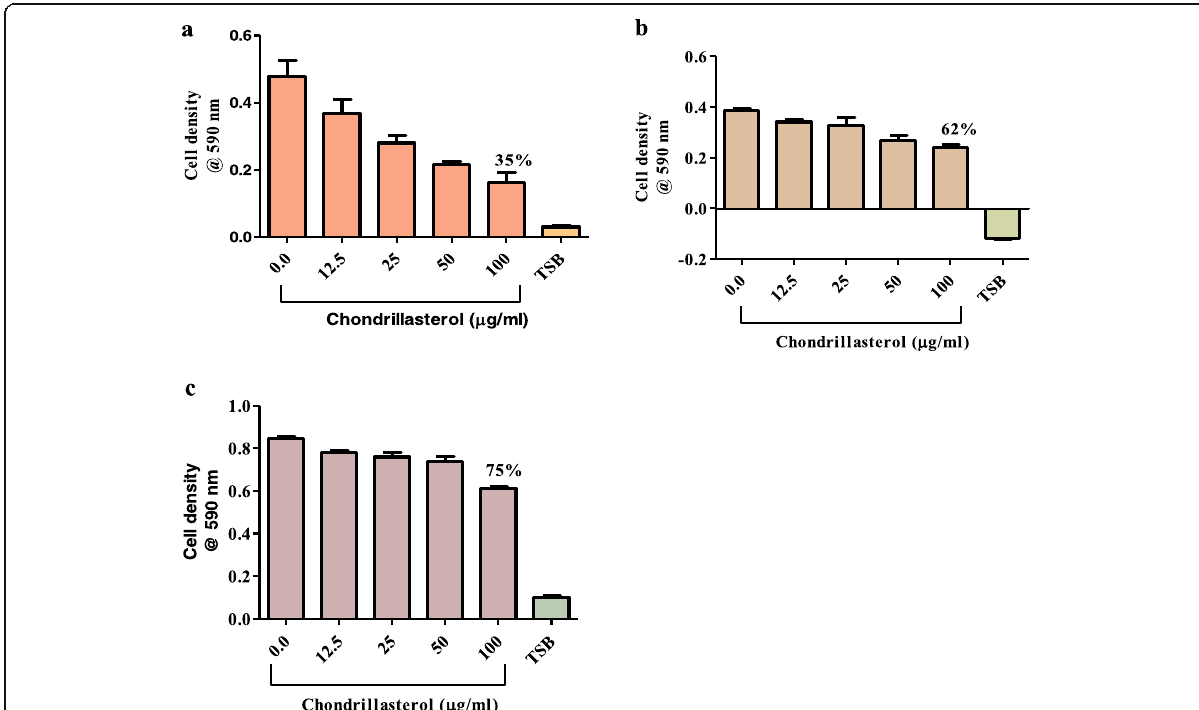
Fig. 4 The effect of chondrillasterol on growth of bacteria pathogens. The pathogens were susceptible to chondrillasterol and ( a ) is % remaining viable cells for P. aeruginosa , and ( b ) is % of remaining viable cells for K. pneumoniae while ( c ) is % of remaining viable cells for S. aureus following exposure to chondrillasterol. Concentrations of 1.6 × 10 6 cfu/mL of bacteria were used. Values are expressed as mean cell density at 590 nm